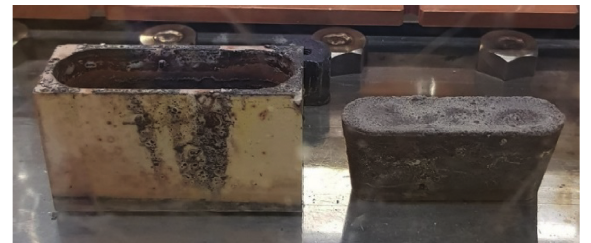
Figure 4: Photographs of the LCC crucible and Cd ingot after run 1.